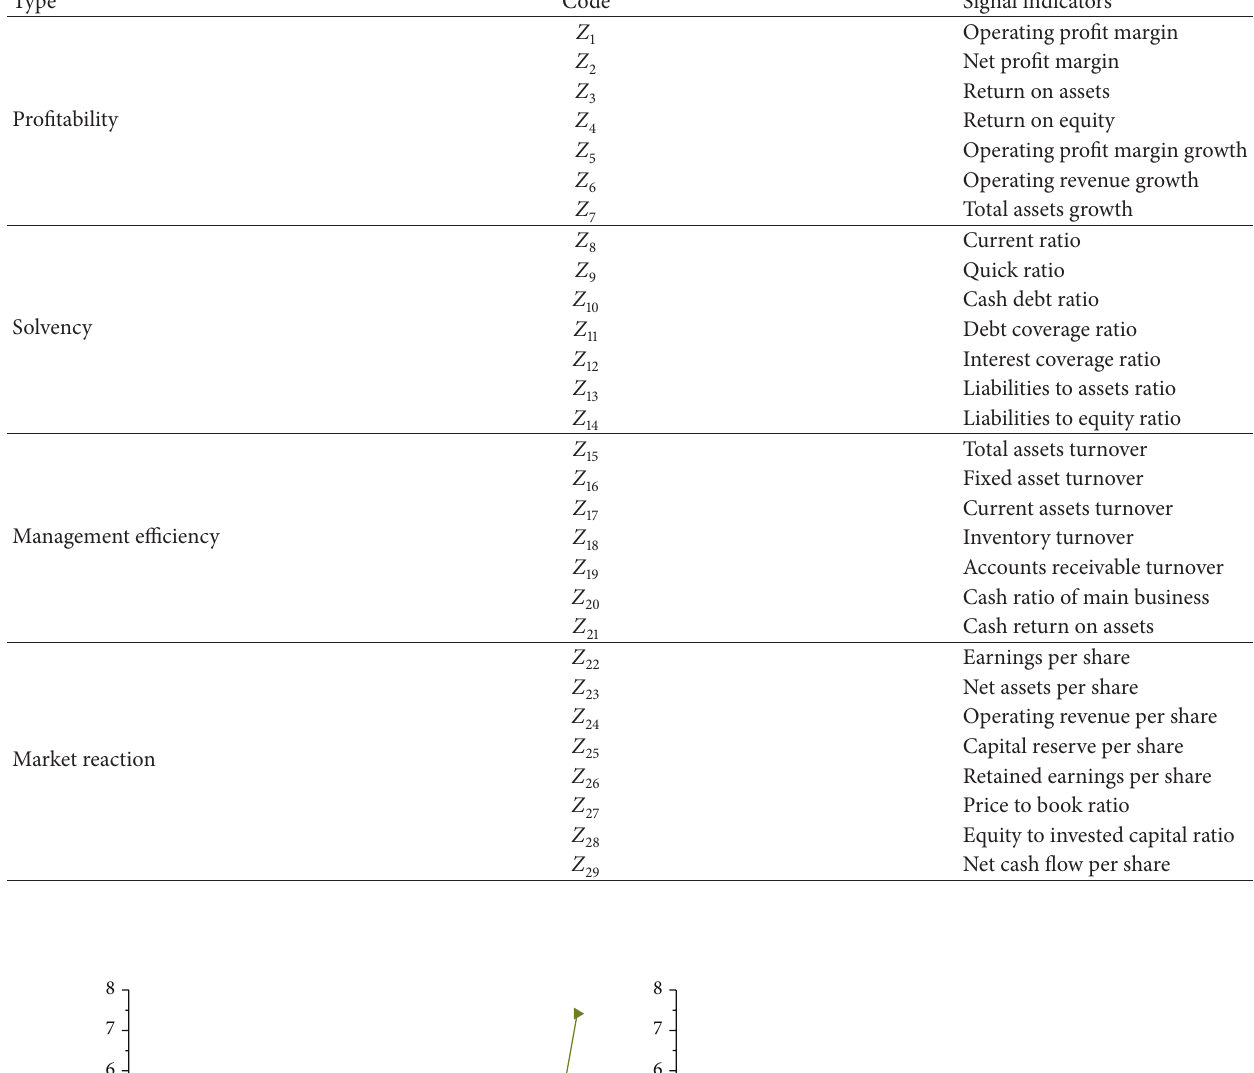
Table 1: Comprehensive signal indicators of financial distress prediction.